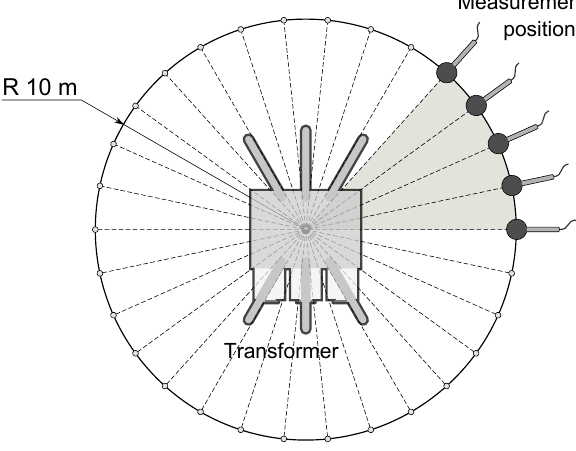
Figure 4. Measurement positions for directivity measurements.